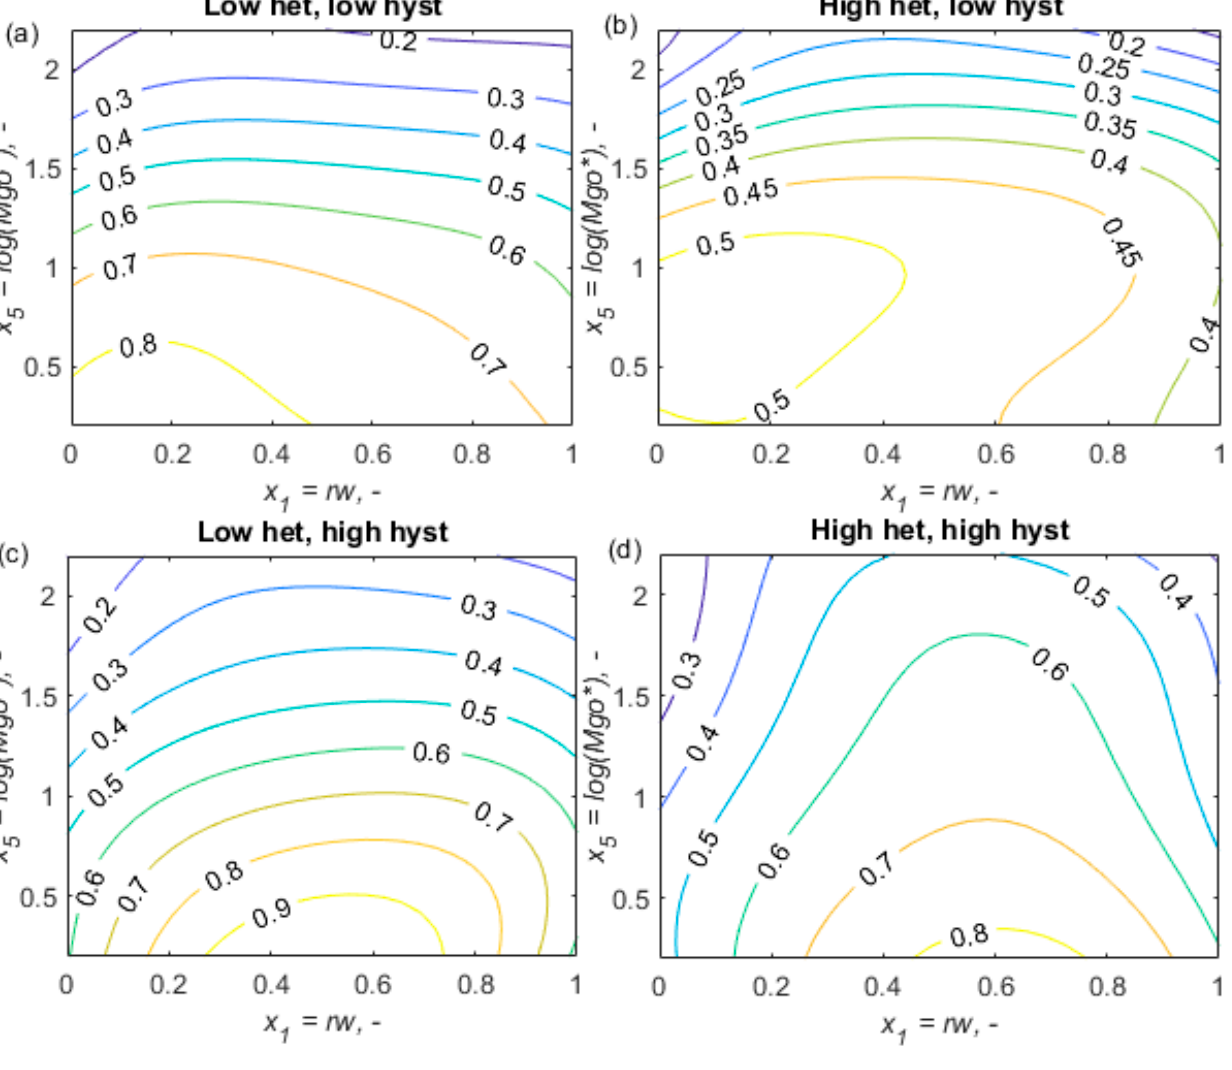
Figure 9. Contour plots of recovery factor RF plotted against 𝑥 (cid:2869) (cid:3404) 𝑟 (cid:3050) and 𝑥 (cid:2873) (cid:3404) 𝑙𝑜𝑔(cid:3435)𝑀 (cid:3034)(cid:3042)∗ (cid:3439) . The latter represents variation in oil viscosity, which affects all of 𝑥 (cid:2873) , 𝑥 (cid:2874) , 𝑥 (cid:2875) , 𝑥 (cid:2876) . The four cases are for low heterogeneity and hysteresis ( a ), high heterogeneity and low hysteresis ( b ), low heterogeneity and high hysteresis ( c ) and high heterogeneity and hysteresis ( d ). See all input values in Table 5.